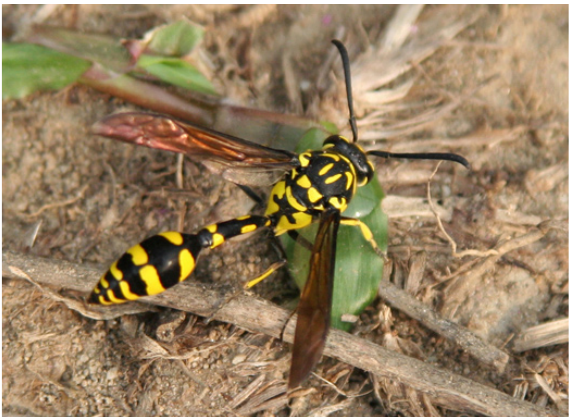
Image 6. Phimenes flavopictum continentale (Zimmermann, 1931)